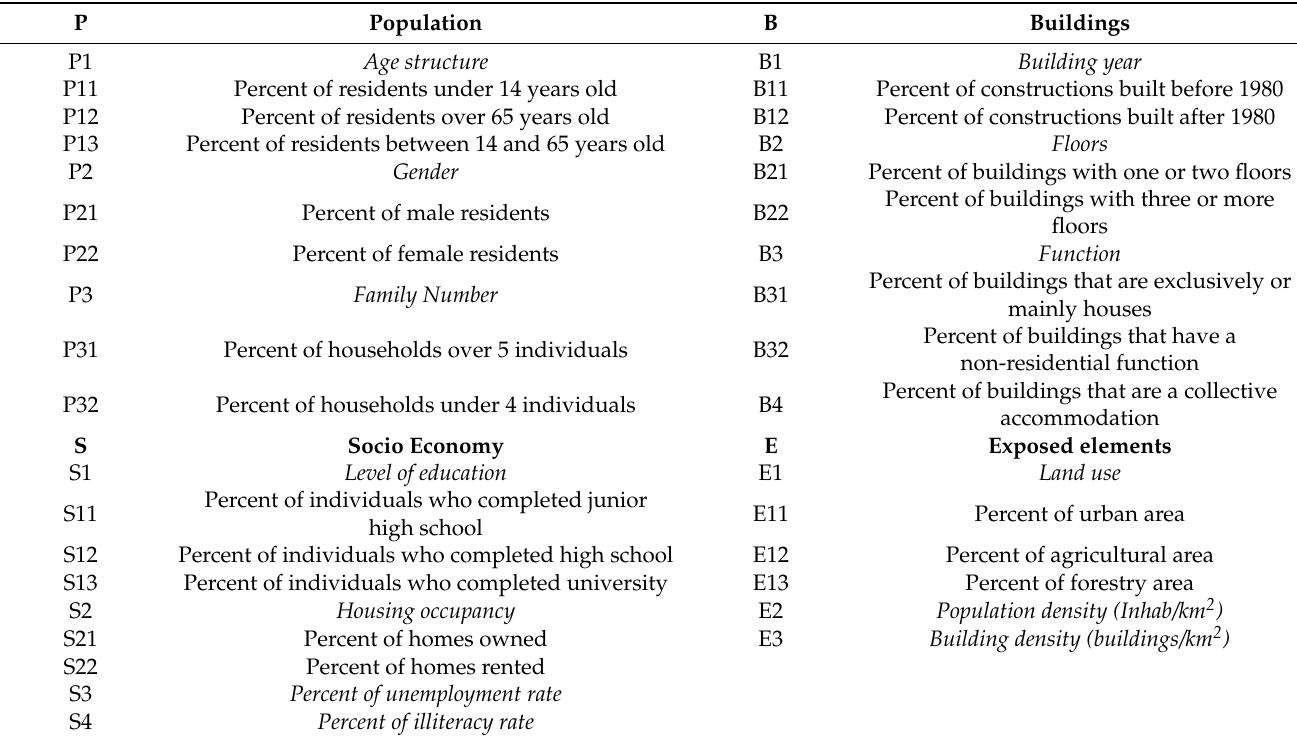
Table 1. Description of the data used in the